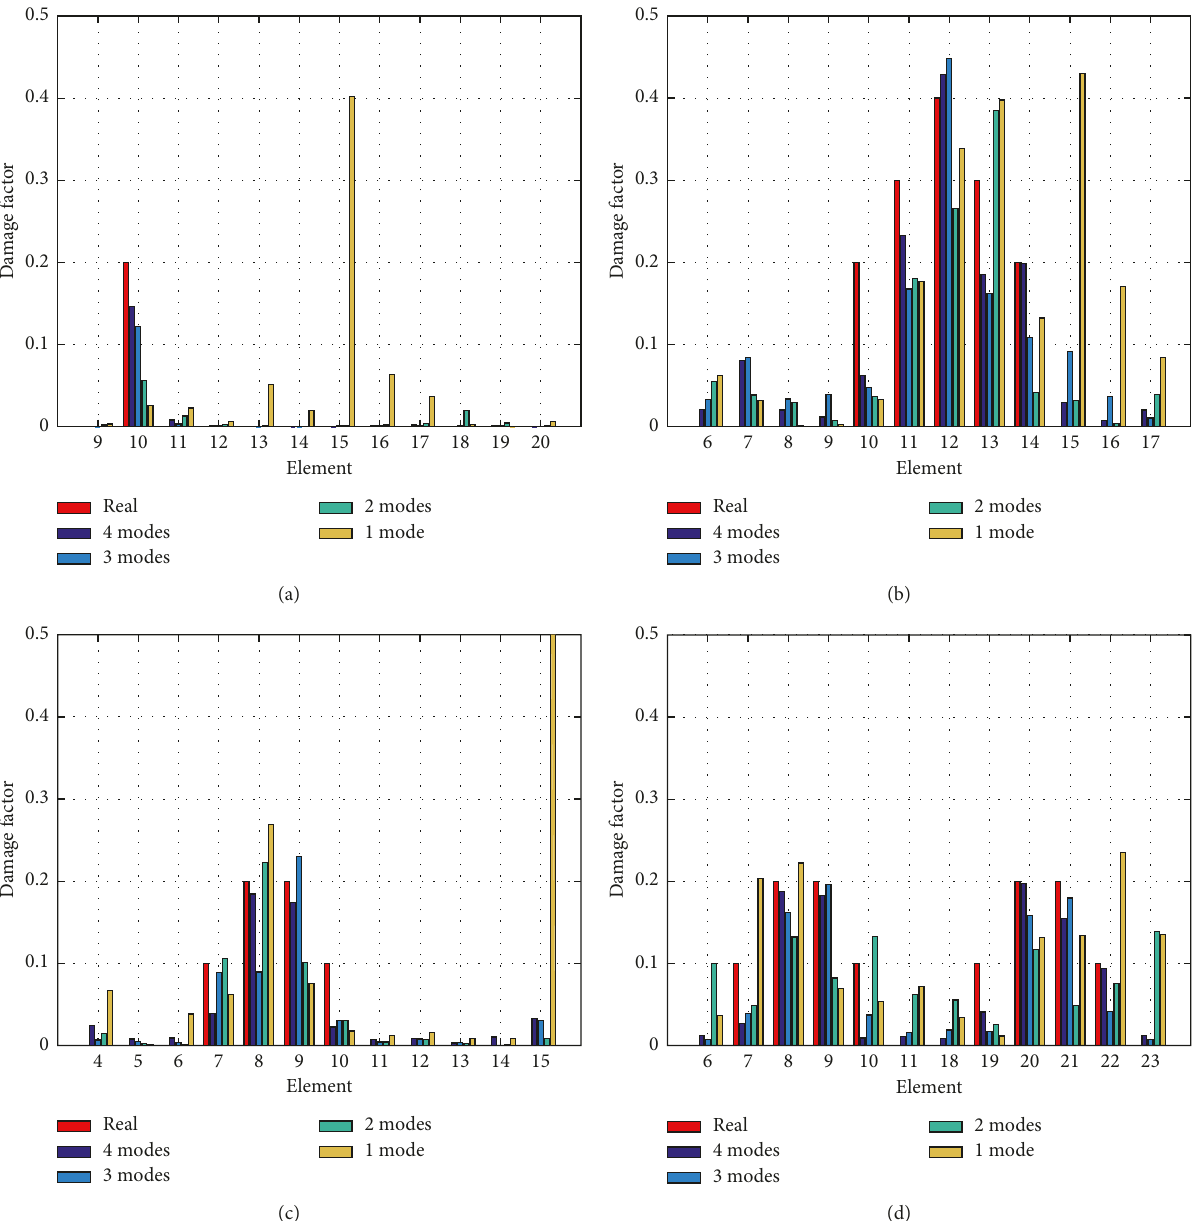
Figure 12: Frame example: damage prediction of the MTMAC criterion for the four damage scenarios (no noise). (a) Scenario 1, (b) scenario 2, (c) scenario 3, and (d) scenario